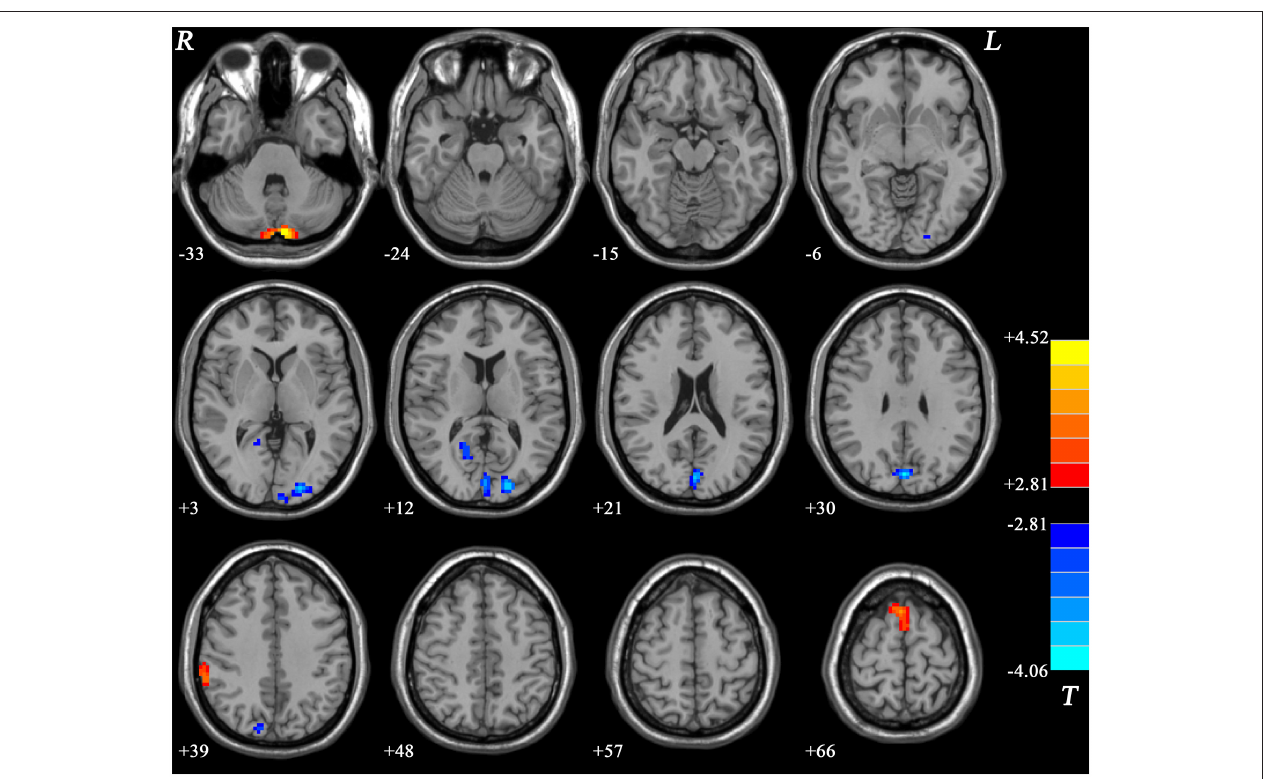
FIGURE 4 | Statistical map depicts higher and lower ReHo in GI group compared with healthy controls. The threshold was FDR (false discovery rate) corrected at p < 0.05. Blue denotes lower ReHo and red denotes higher ReHo in the GI group. The color bar indicates T values from post-hoc t -tests. L, lest side; R, right side; GI, gastrointestinal; ReHo, regional homogeneity.